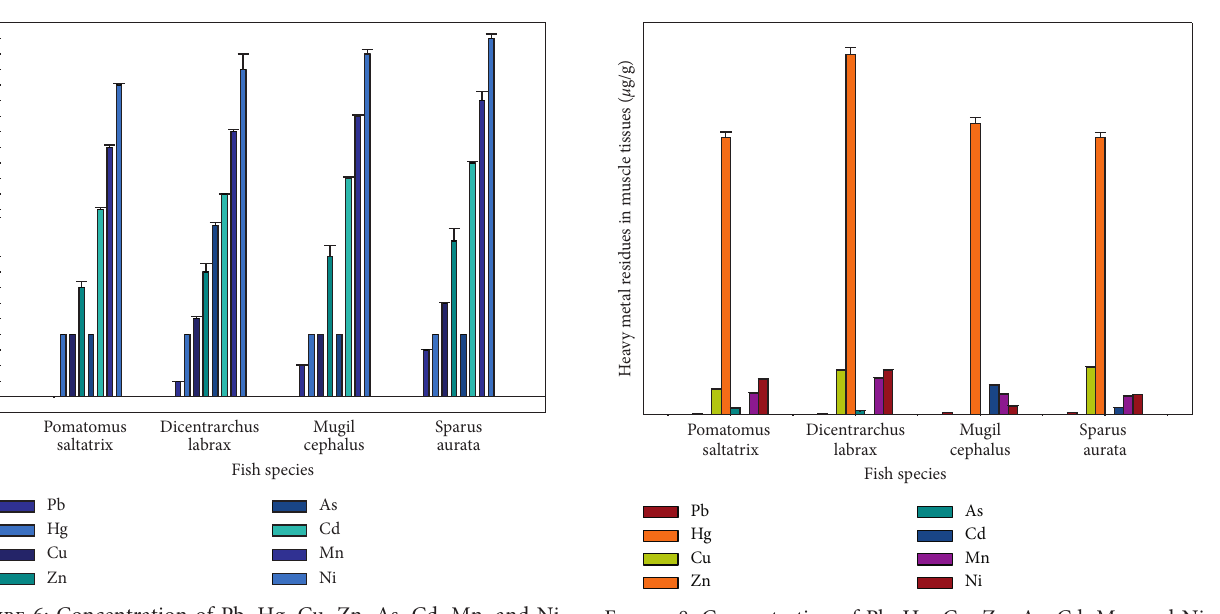
Figure 8: Concentration of Pb, Hg, Cu, Zn, As, Cd, Mn, and Ni residues ( μ g/g) in muscle tissues of fish samples from Istanbul, Cost of Black Sea.